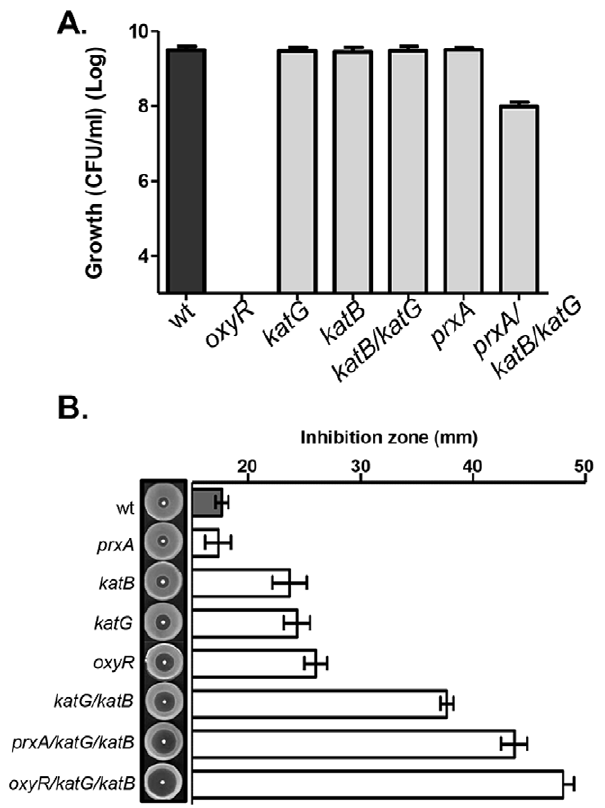
Figure 2. Aerobic growth and H 2 O 2 resistance of wildtype, oxyR , and catalase mutants. A. Overnight cultures of V. cholerae strains were inoculated at 1:1000 into fresh LB and shaken at 37 u C for 6 hrs. Viable cells were counted by serial dilution and plating on LB agar plates containing 1/10 (v/v) cell-free supernatants prepared from wildtype cultures. B. Disc diffusion plate assays. Approximately 10 8 bacterial cells were mixed with top LB agar and discs saturated with 6 M H 2 O 2 were placed in the middle. The plates were incubated at 37 u C for 8 hrs and the diameter of the inhibition zone was measured for each strain. Data are mean and s.d. of three independent experiments.